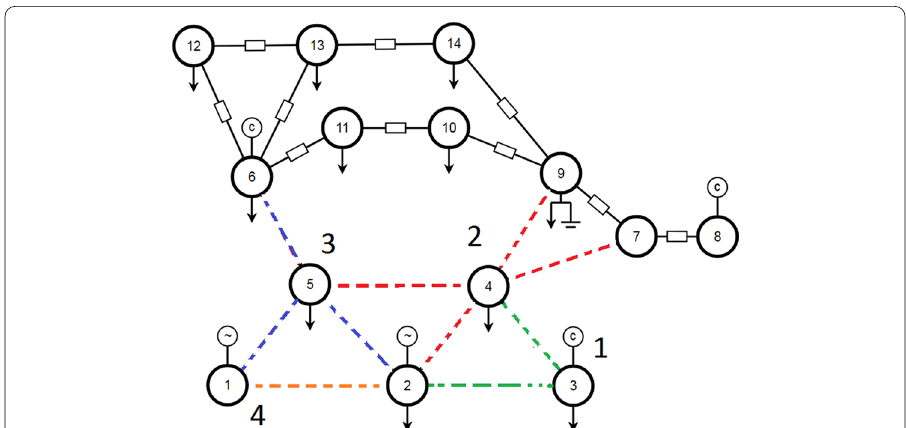
Fig. 5 IEEE 14-bus test grid applying the EMDE failure sequence [3, 4, 5, 1]. The dashed lines are the links (transmission lines) disconnected after the removal of the EMDEs